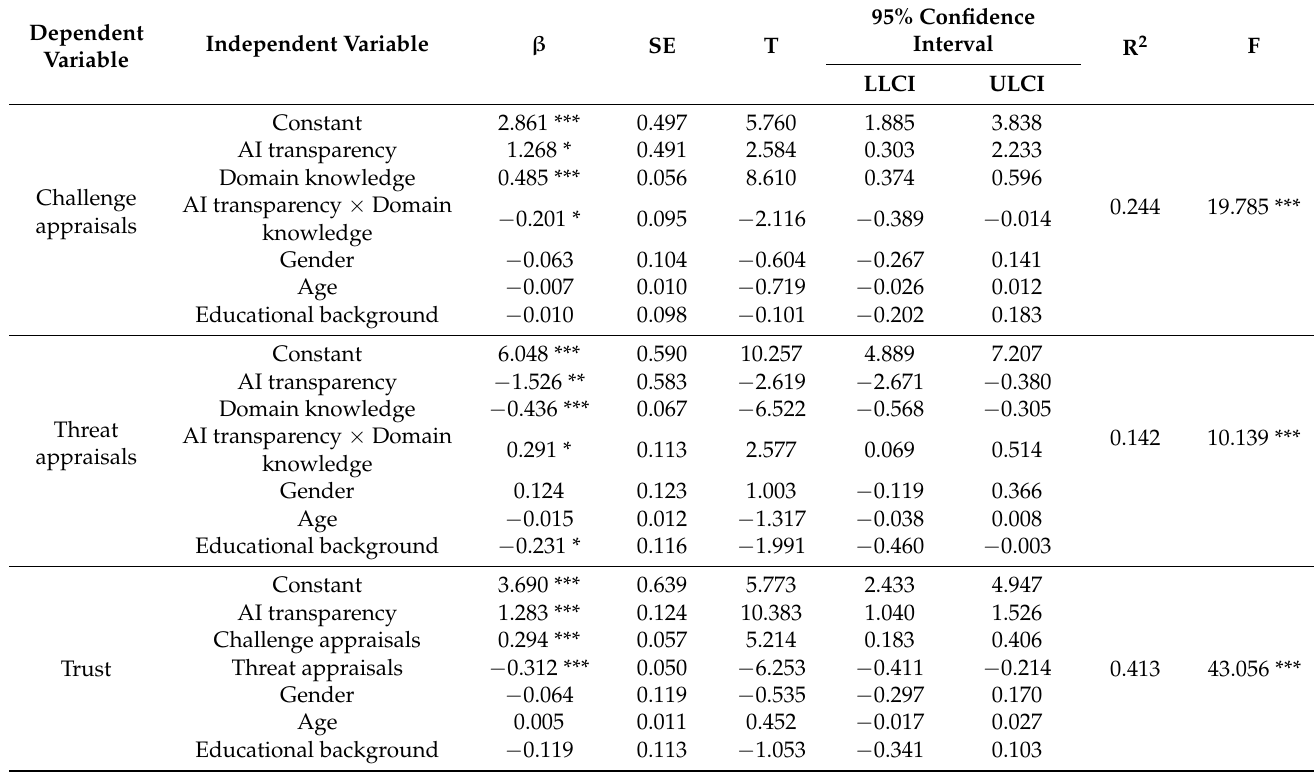
Table 8. The results of the moderating